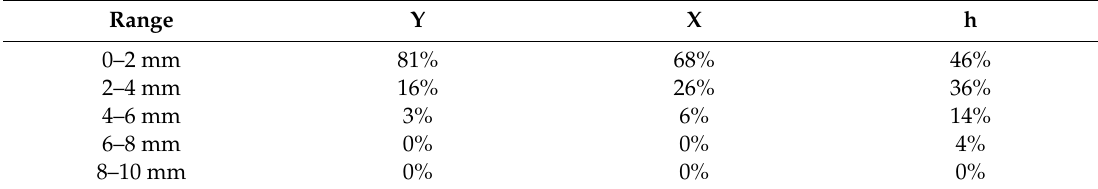
Table 4. Residual classification for G-baseline.